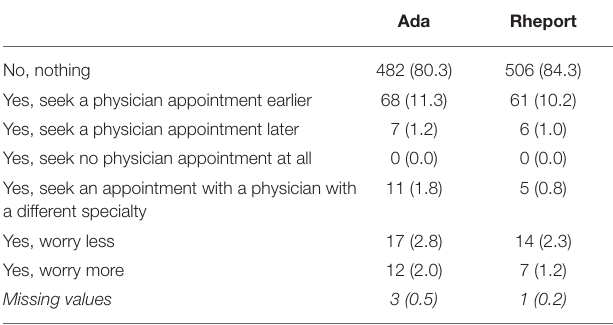
TABLE 4 | Self-reported potential effects of diagnostic decision support system assessments a . Would you have done anything different having used the DDSS? n